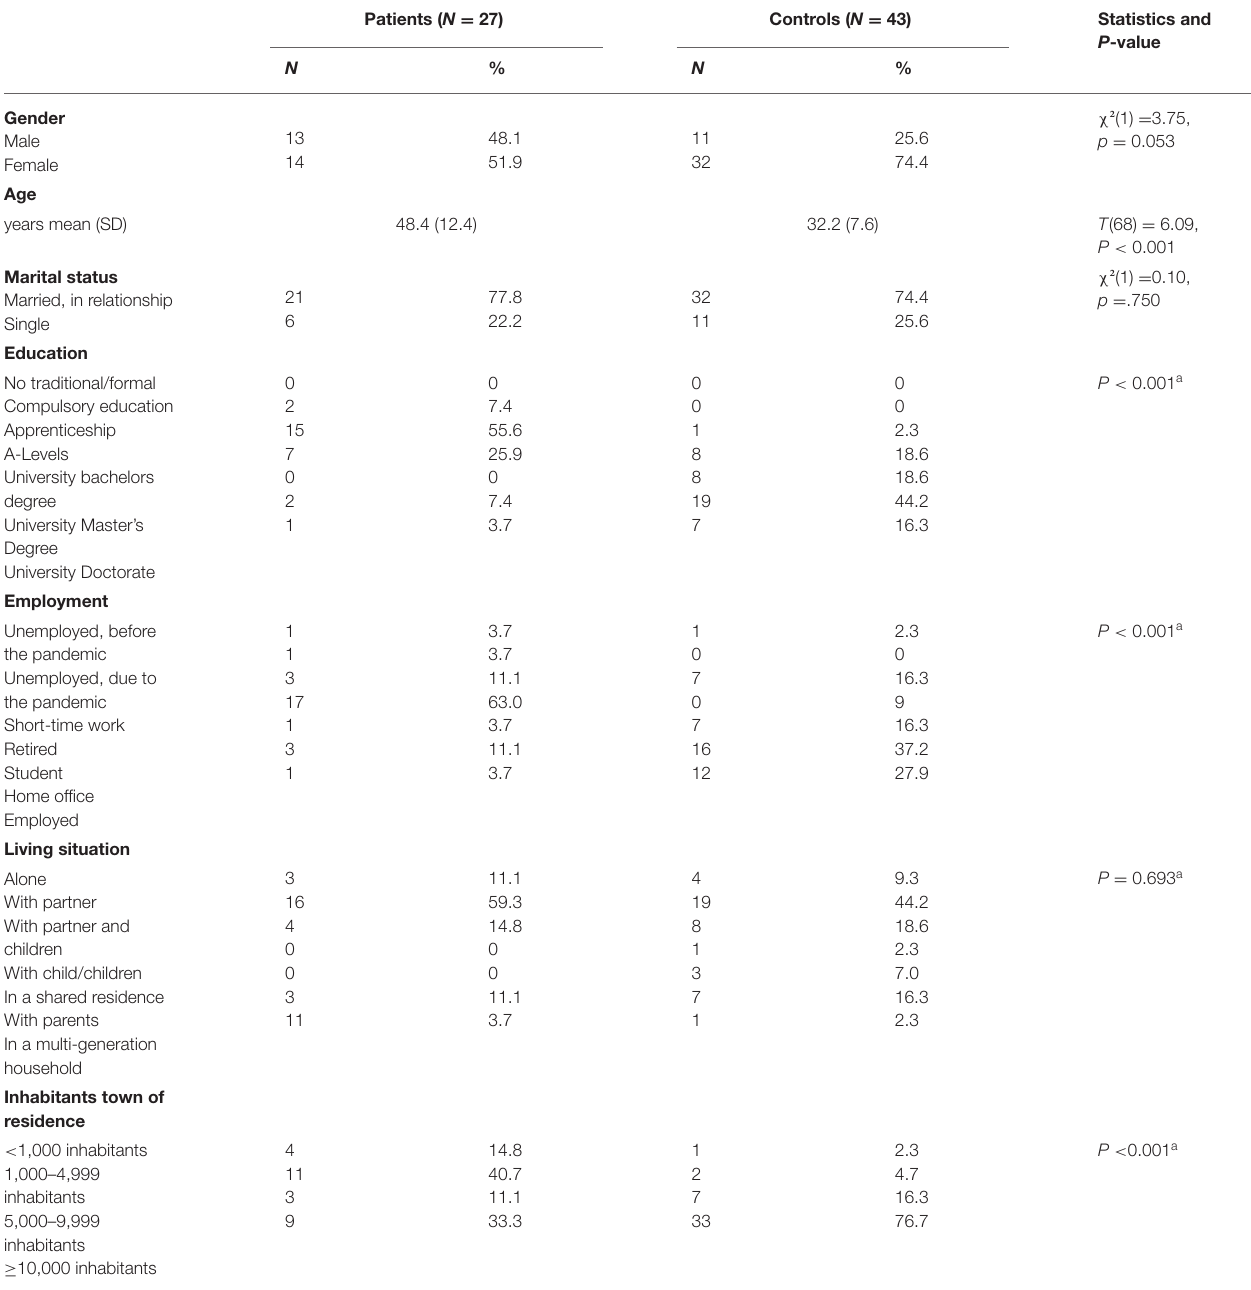
TABLE 1 | Demographic data. Patients ( N = 27) Controls ( N = 43) Statistics and